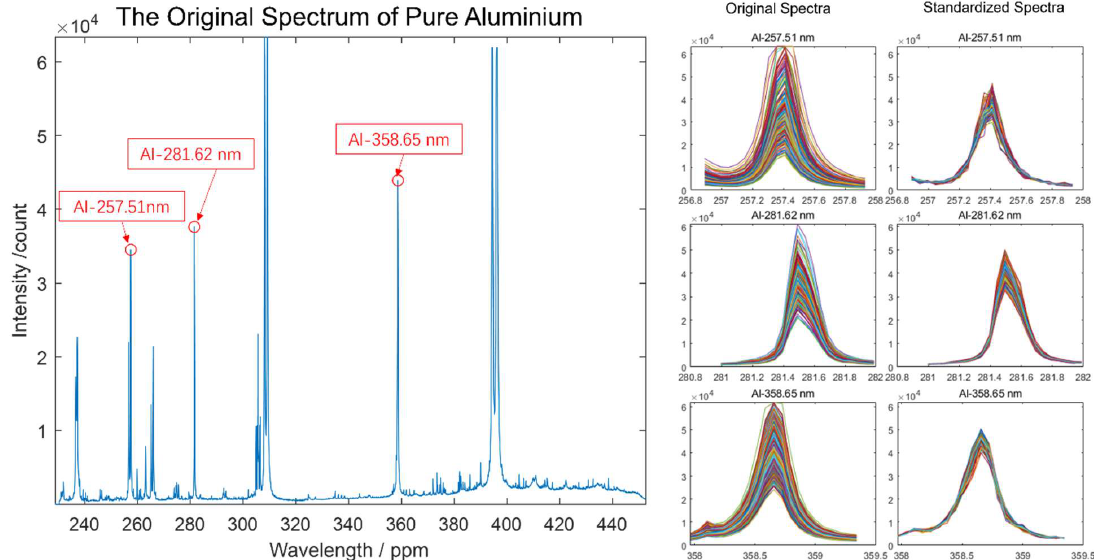
Figure 4. The original averaged spectrum of pure aluminium from the training set and the three Al characteristic lines selected for the KPBP experiment ( left ). The eye patterns of the characteristic spectral segments ( right ).